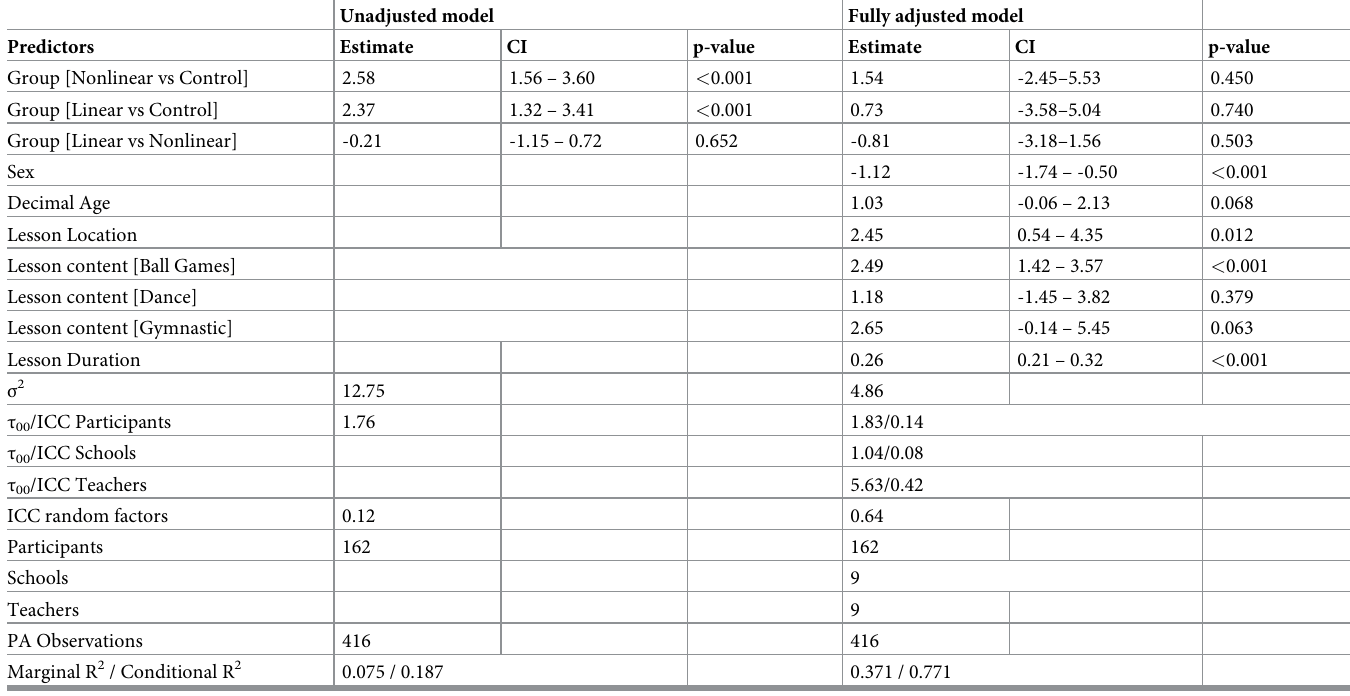
Table 4. Association between pedagogy group and children’s minutes of moderate to vigorous physical activity during physical education. Unadjusted model Fully adjusted